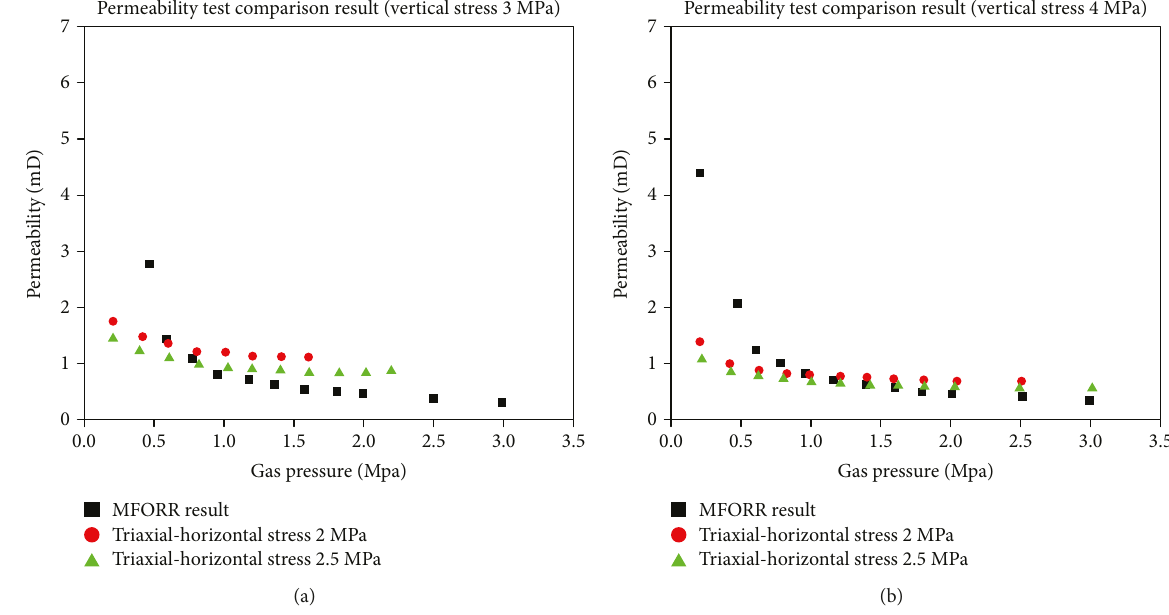
Figure 8: MFORR permeability and triaxial permeability test results comparison (Ref. Table 3: Classi fi cation of coalbeds based on their permeability (after Ref. [45]).